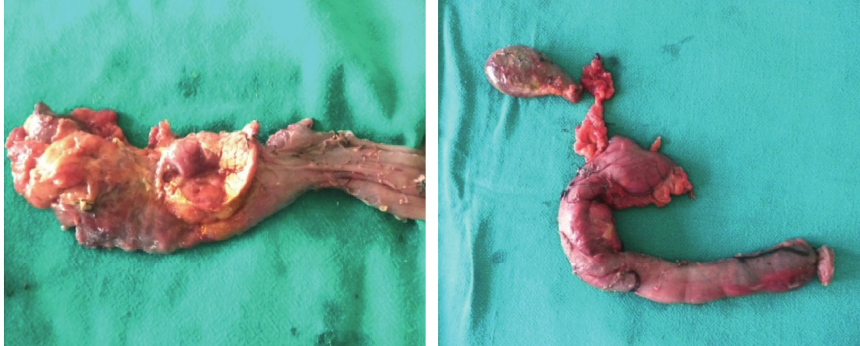
Figure 3: Postoperative